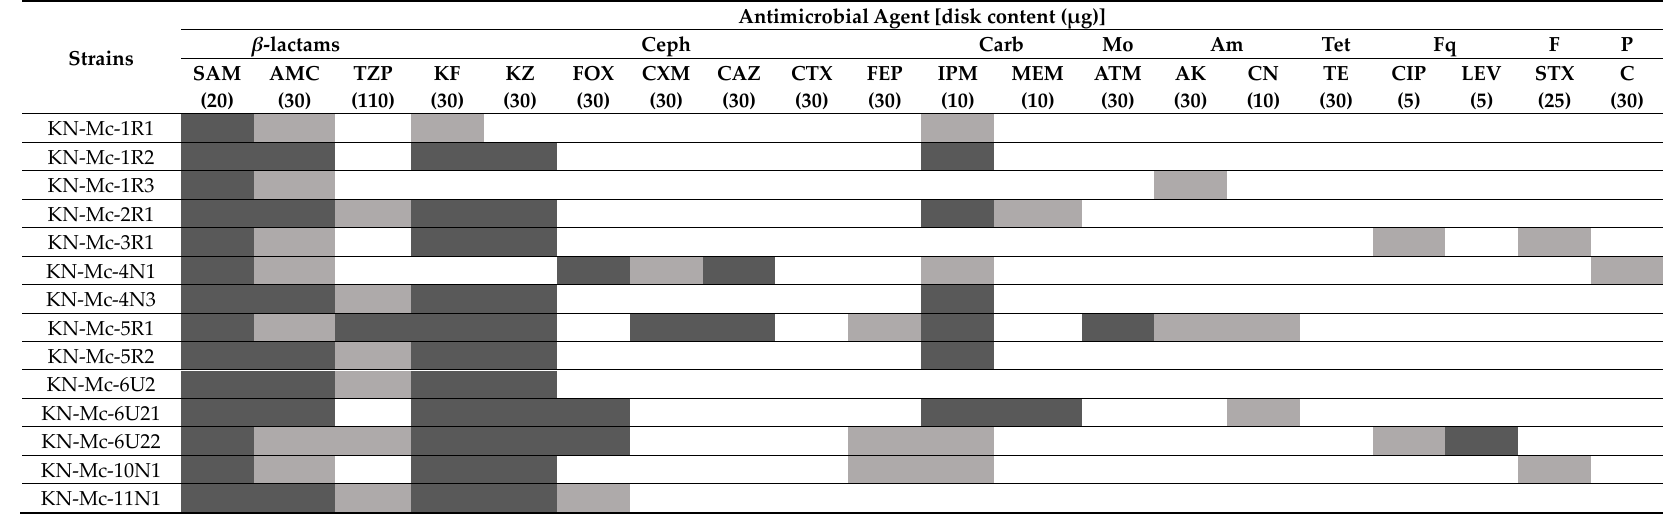
Table 3. Antibiotic resistance profile of the 14 Aeromonas isolates as determined by disk diffusion testing.